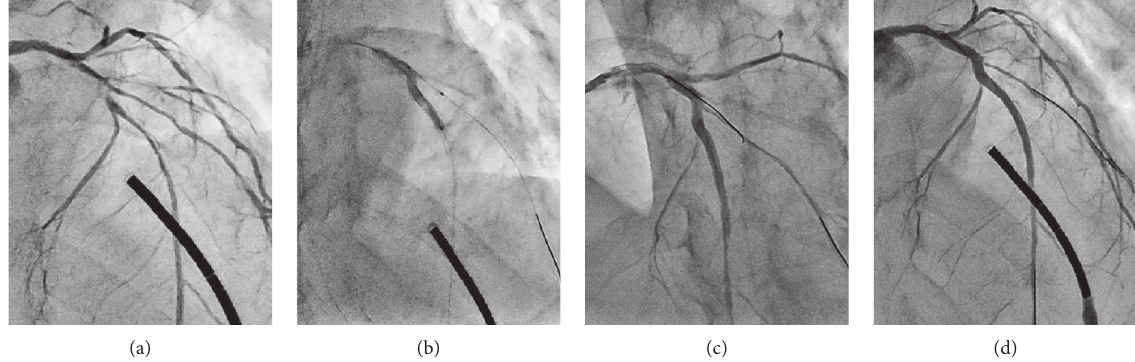
Figure 1: A caseof stenosisincrease intheSB ostium afterthemodifiedjailed balloontechnique. (a)A controlangiographicimage ofthetargeted bifurcated lesion in the mid-LAD artery. (b) DES deployment simultaneously with 1.5 mm jailed balloon inflation in SB. (c) After the modified jailed balloon technique, arterial dissection developed in the SB ostium. (d) Final angiography with stenosis increase in the SB ostium.